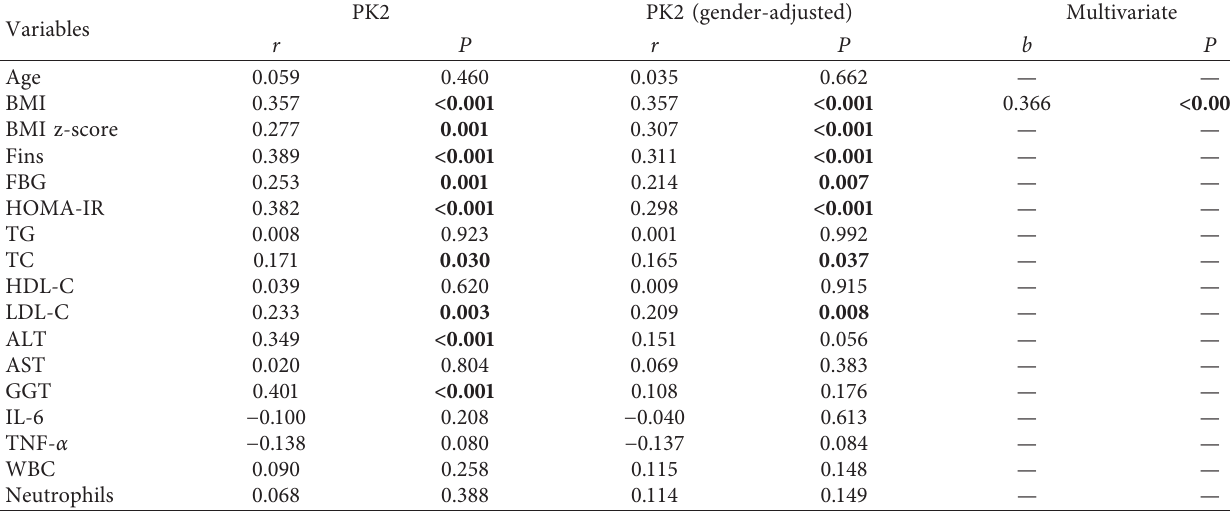
Table 3: Correlation analysis between prokineticin 2 and biochemical data in all participants.